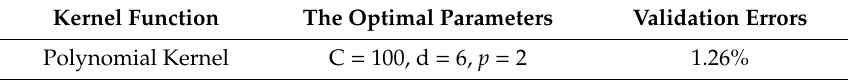
Table 4. Cross-validation